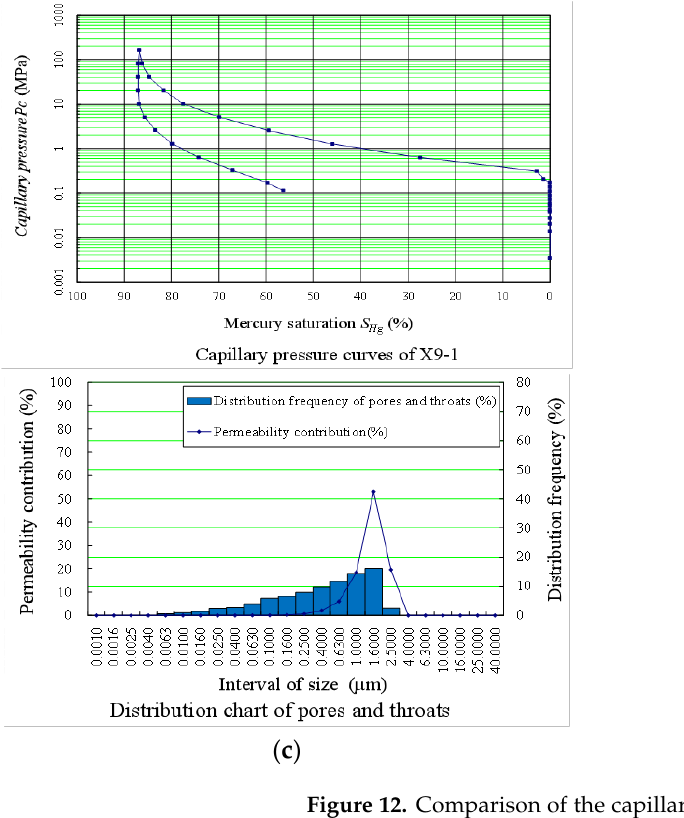
Figure 12. Comparison of the capillary pressure curves of four subcategories of sandstone, showing the differences in the pores, pore throats and their permeability contributions among the four subcategories of sandstone: ( a ) Subcategory I 1 sandstone shows a lower left distribution, well-sorted pore throats, coarse throat peaks at 4 to 6 µm, and a higher peak; nearly all of the pore throats contribute to the permeability. ( b ) Subcategory I 2 sandstone shows a slight lower left distribution, well- to moderately sorted pore throats, coarse throat peaks at 1.6 to 4 µm, and a high peak; most of the pore throats contribute to the permeability. ( c ) Subcategory II 1 sandstone shows a slight upper right distribution, moderately to poorly sorted pore throats, coarse throat peaks at 1 to 1.6 µm, and a moderate to low peak; approximately half of the pore throats contribute to the permeability, but with large differences. ( d ) Subcategory II 2 sandstone shows an upper right distribution, poorly sorted pore throats, coarse throat peaks at 0.0063 – 0.1 µm, and a lower peak; minute amounts of pore throats contribute to the permeability.